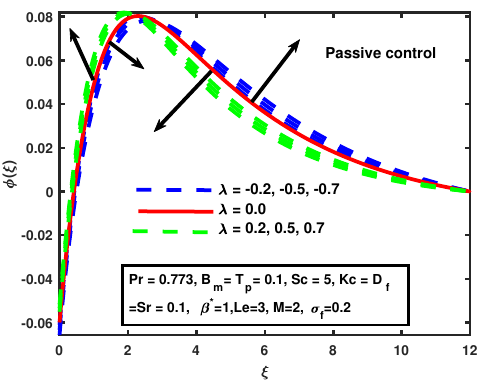
Figure 17. The impact of φ ( ξ ) on suction/injection λ (passive control